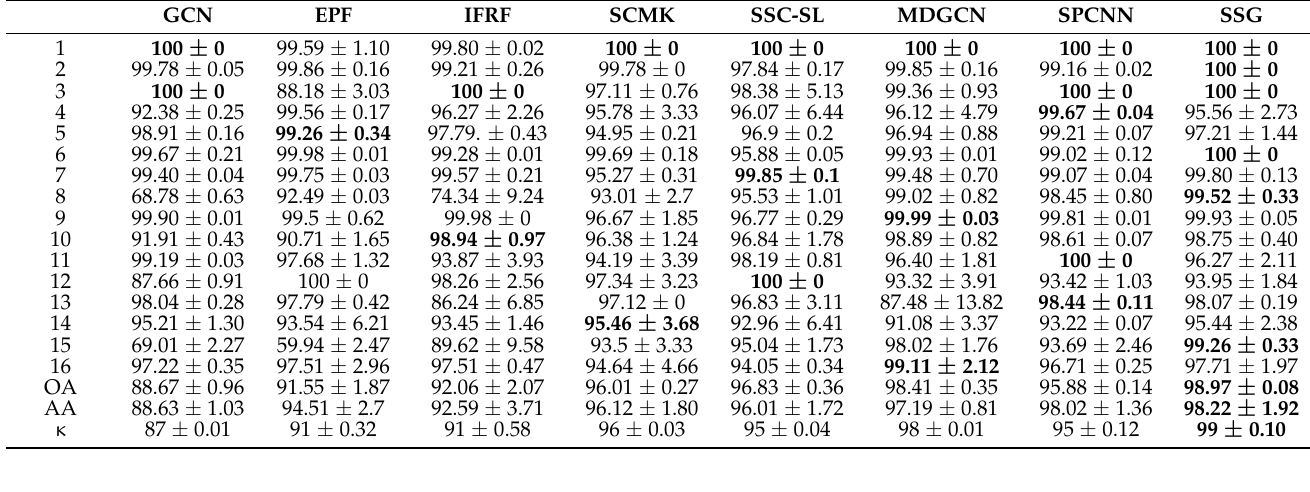
Table 4. Classification results (%) of eight spatial-spectral approaches on Salinas.